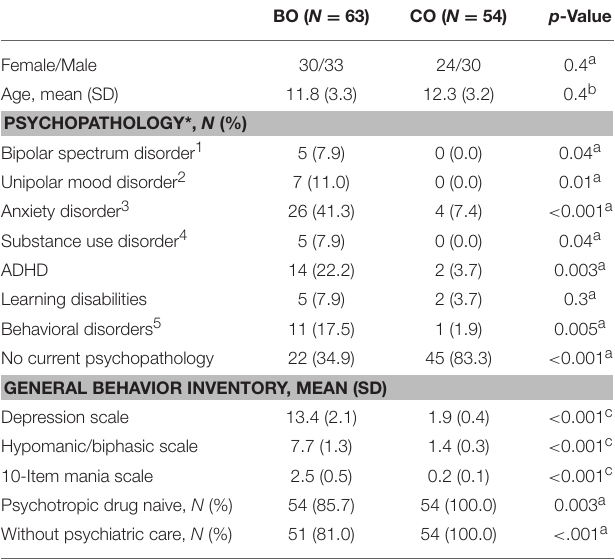
TABLE 1 | Demographic and current clinical variables of the BO and CO groups.